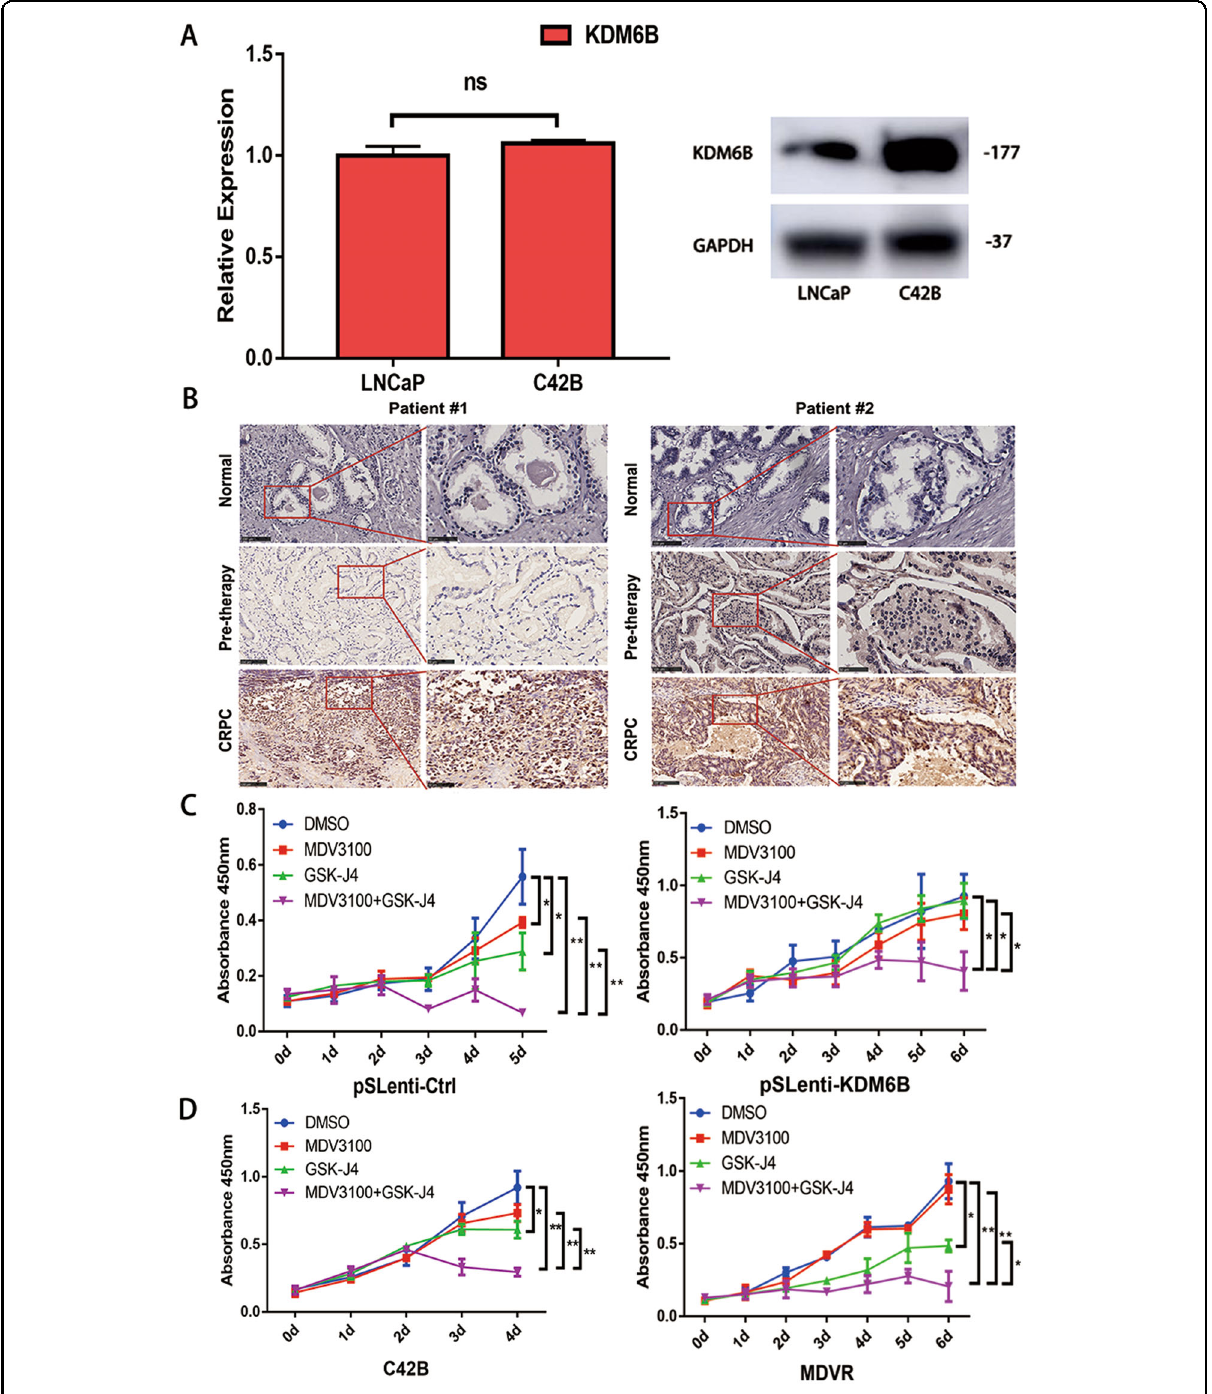
Fig. 4 KDM6B is involved in the development of CRPC. A Comparison of KDM6B mRNA and protein expression between LNCaP and C42B cells. Error bars means SD, n = 3 independent repeats. B The immunochemistry results of KDM6B in normal prostate tissue, pretherapy prostate cancer tissue, and castration-resistant prostate cancer tissue are shown. C Single MDV3100 and GSK-J4 treatment failed to suppress the proliferation of pSLenti- KDM6B -transfected LNCaP cells, but the phenomenon could be terminated by the combination of MDV3100 plus GSK-J4. Error bars means SD, n = 3 independent repeats. D Combination of MDV3100 plus GSK-J4 was effective for CRPC C42B cells and MDV3100-resistant CRPC MDVR cells. Error bars mean SD, n = 3 independent repeats (ns: not signi fi cant, * p < 0.05, ** p < 0.01; MDV3100, enzalutamide; DMSO,